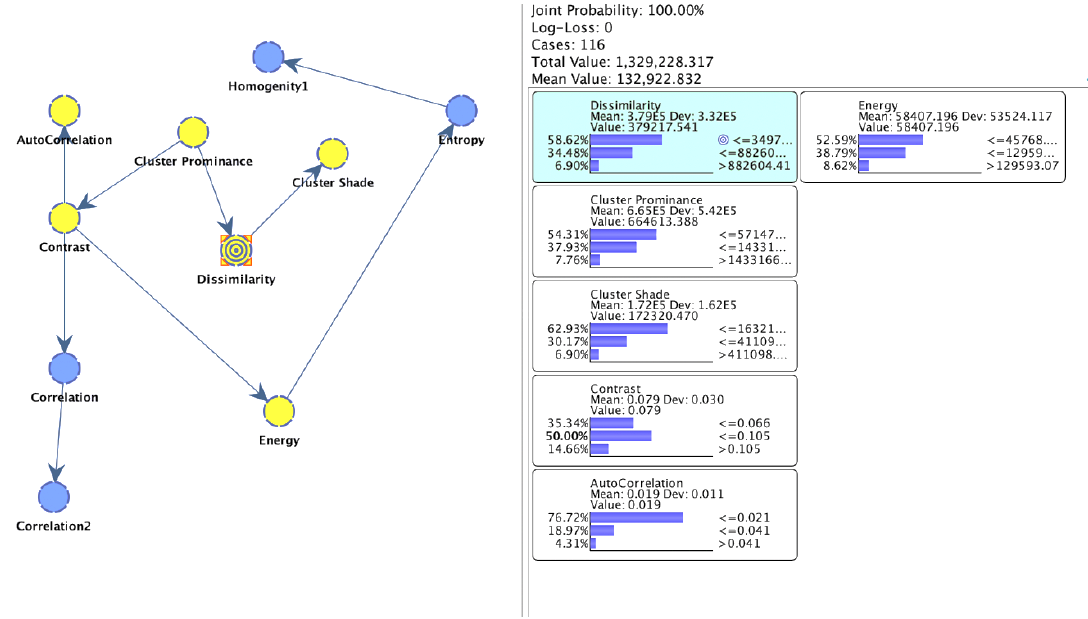
Figure 5. Unsupervised clustering when dissimilarity was selected as the target node.